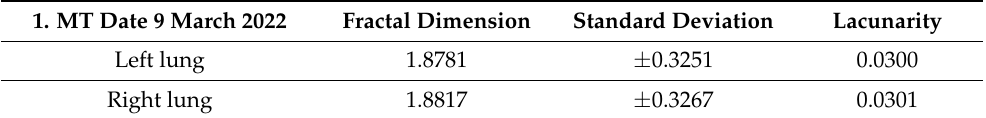
Table 1. Fractal indicators for the first patient.